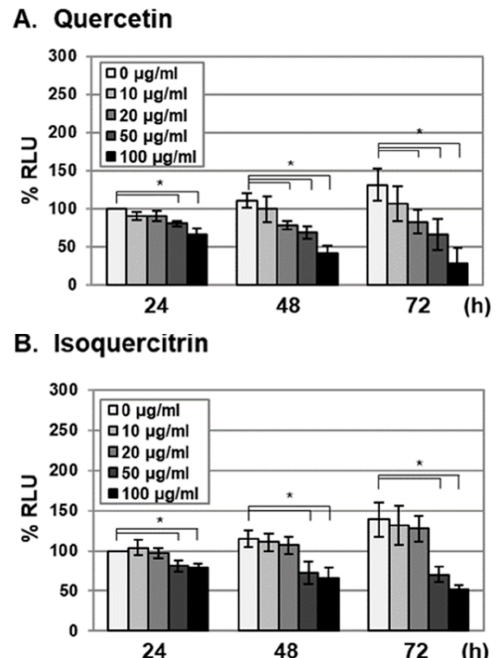
Figure 3. Cytotoxic effects of quercetin and isoquercitrin against HFF cells. HFFs were treated with ( A ) quercetin or ( B ) isoquercitrin at concentrations of 0, 10, 20, 50, and 100 µg/mL. At 24, 48, and 72 h after treatment, cell viability was determined by measuring cellular ATP levels using the CellTiter-Glo ® Luminescent cell-viability assay. Significant di ff erences between samples were determined using Student’s t test (significant at * p < 0.05). Data shown here represent three independent sets of experiments. RLU, relative luciferase